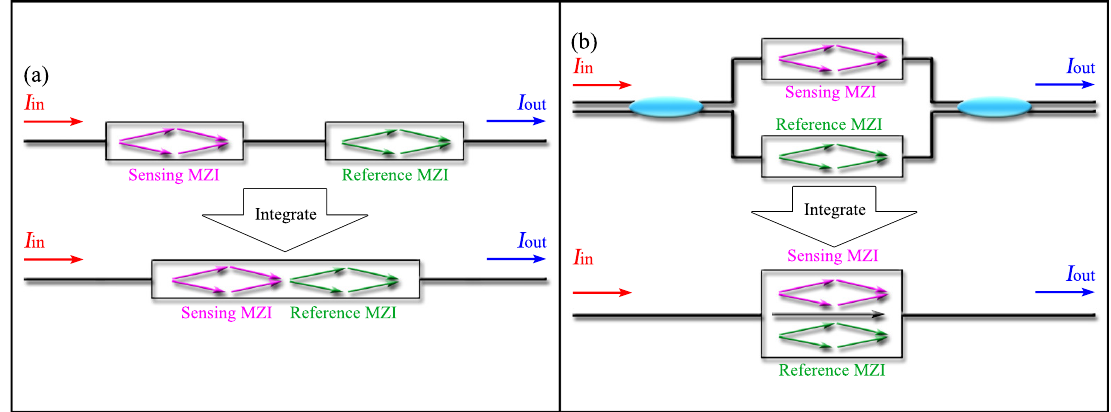
Figure 5. Vernier effect fiber sensor with: ( a ) cascaded MZIs; ( b ) parallel connected MZIs.